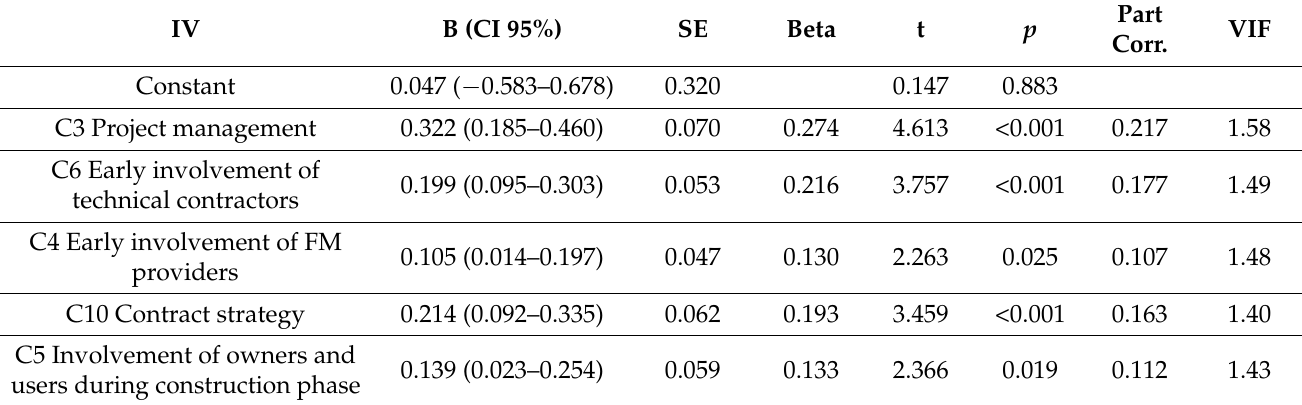
Table 7. Multiple regression with project output C2 Completed building’s qualities as dependent